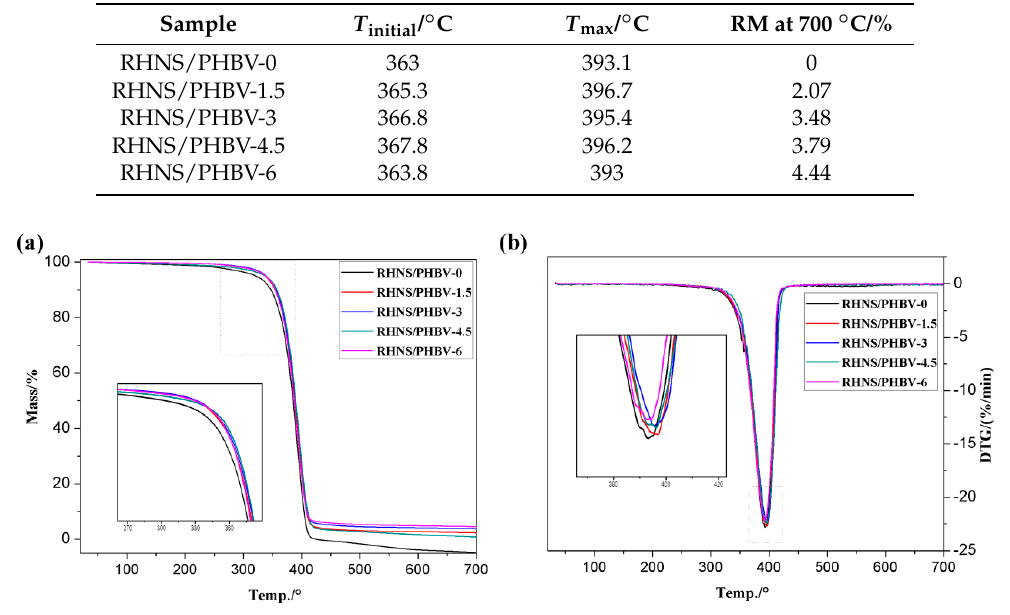
Figure 6. The TGA and DTG curves of RHNS /PHBV composites: ( a ) TGA and ( b ) DTG.